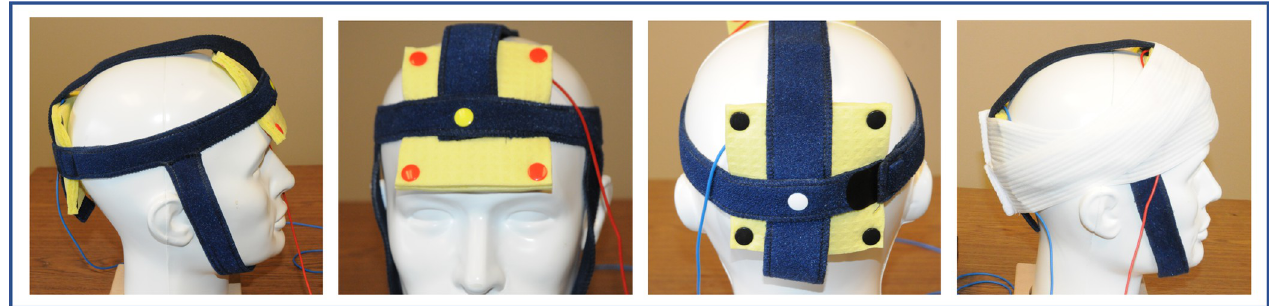
Fig 3. Model of tACS montage used in study. 10x10cm sponges housing carbonized rubber electrodes were placed over the frontal pole above the eyebrows and above the inion and held down with neoprene straps and headbands. Care was taken to avoid causing wetness of the headbands.